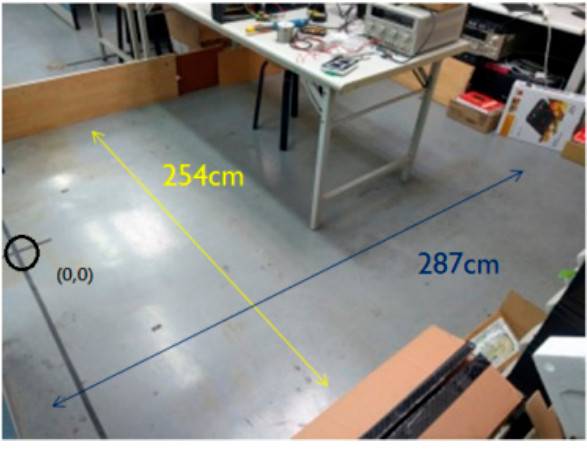
Figure 20. Experimental environment.